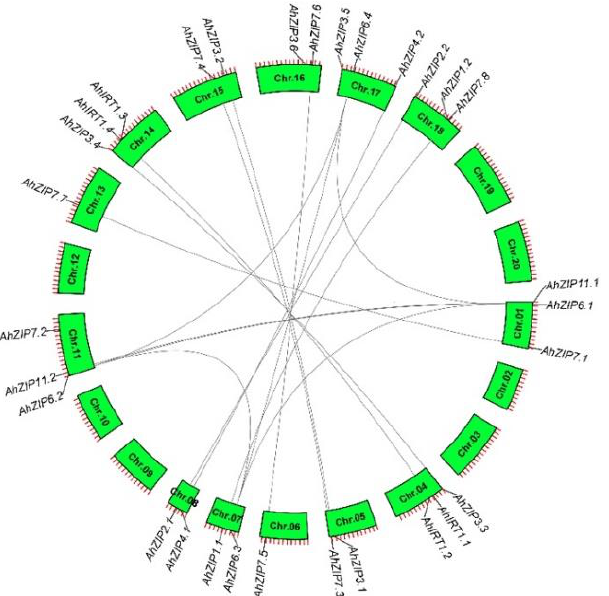
Figure 3. Chromosomal locations and duplications of peanut AhZIP genes obtained from collinearity analysis. Table 2. Ka / Ks analysis of all gene duplication pairs for AhZIP genes. Gene